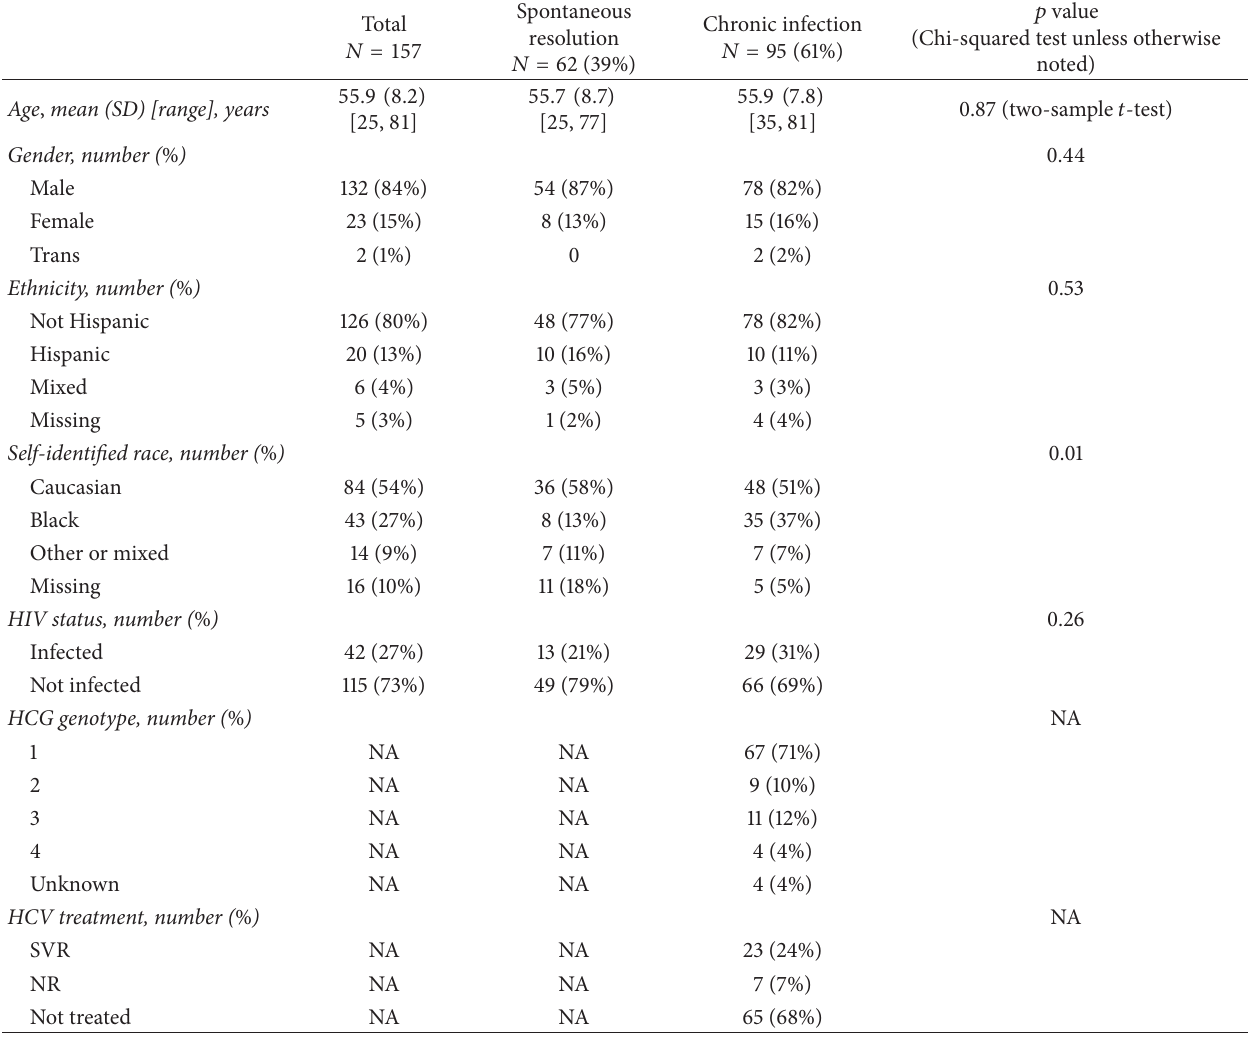
Table 2: Demographic and clinical characteristics of